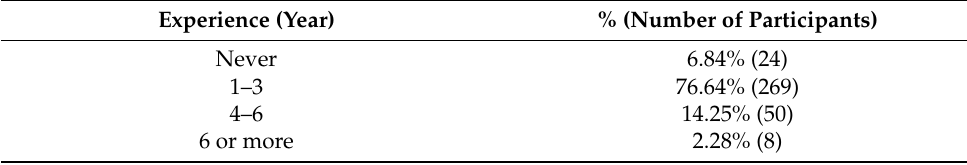
Table 18. Experience with mobile government application